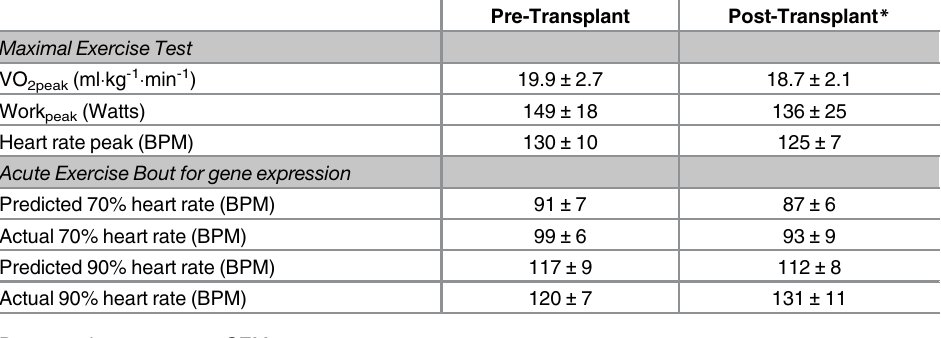
Table 2. Exercise characteristics of